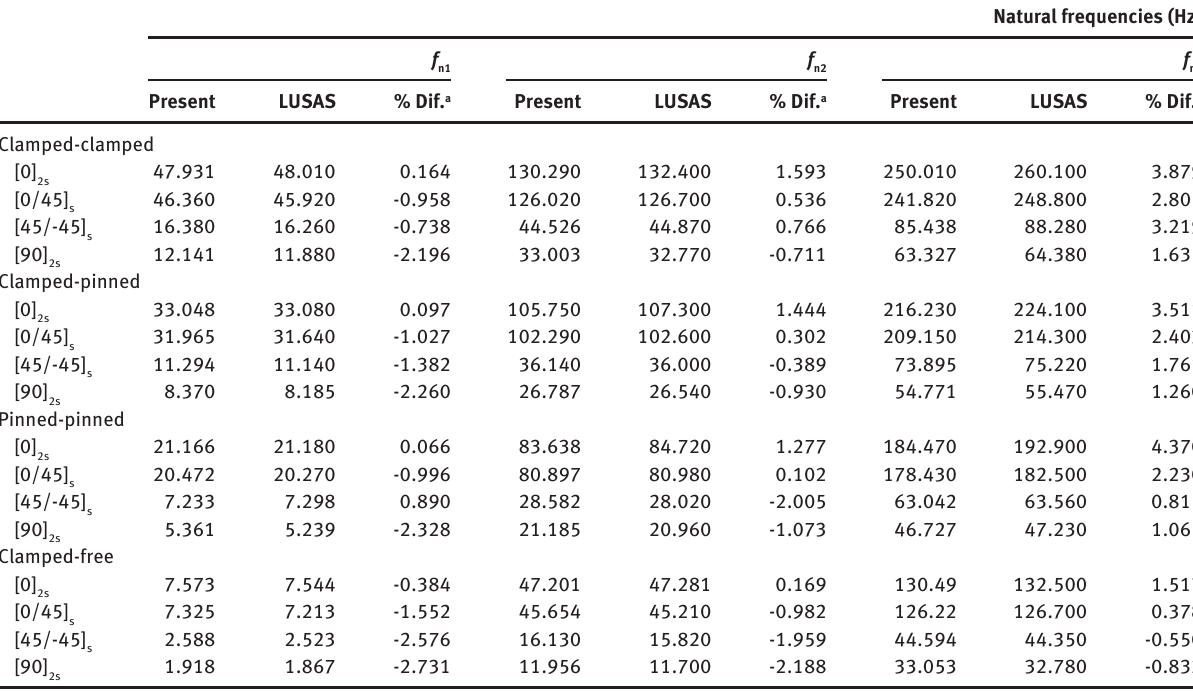
Table 2 Comparison of first three natural frequencies obtained from Matlab code and